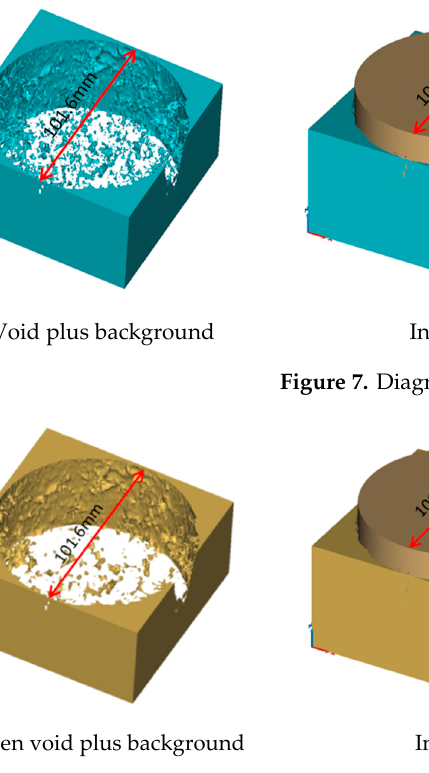
Figure 8. Schematic Diagram of Open Void Calculation.